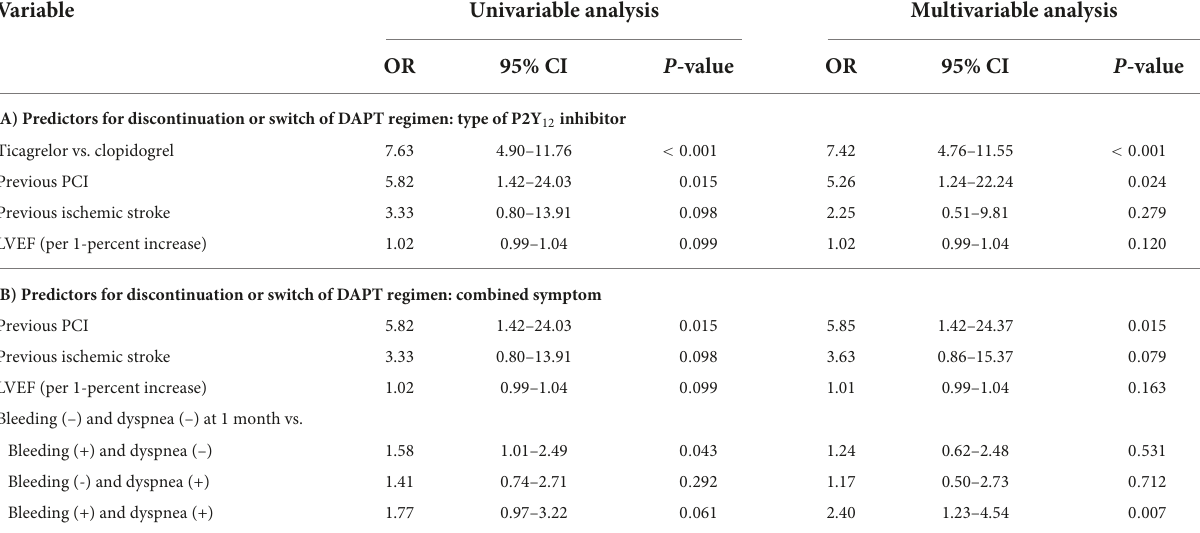
TABLE 5 Predictors for discontinuation or switch of DAPT regimen during 12 months.